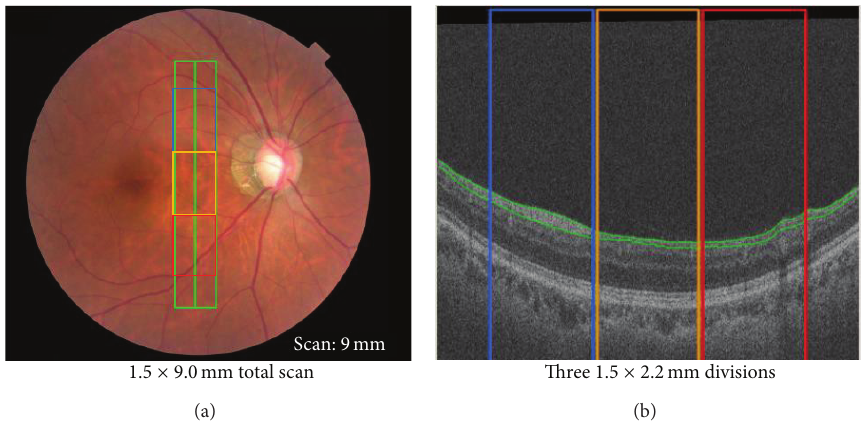
Figure 1: Fundus and optical coherence tomography images of the central papillomacular bundle: a rectangular area centered between the optic nerve disc and the macula, with three lengthwise divisions. (a) Fundus image showing the rectangular scanning area, which is centered between the optic nerve disc and the macula and aligned perpendicularly to the nerve fibers. (b) Representative OCT B-scan image showing sagittal segmentation results. The RNFLT and GCCT were measured in 3 equally sized 1.5 × 2.2 mm sections of the scanning